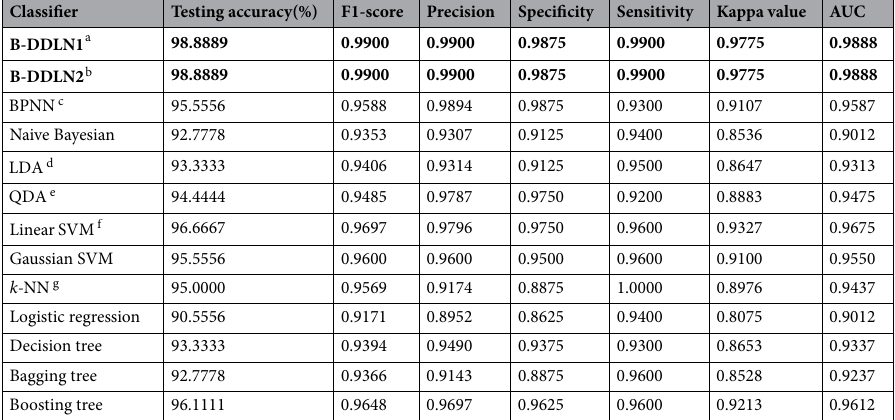
Table 5. Comparison results between B-DDLN and other classifiers for classifying the same extracted image features. The superior performance of the proposed B-DDLN diagnosis model are highlighted in bold. a B-DDLN in case 1. b B-DDLN in case 2. c Back propagation neural network. d Linear discriminant analysis. e Quadratic discriminant analysis. f Support vector machine. g k -nearest neighbor.